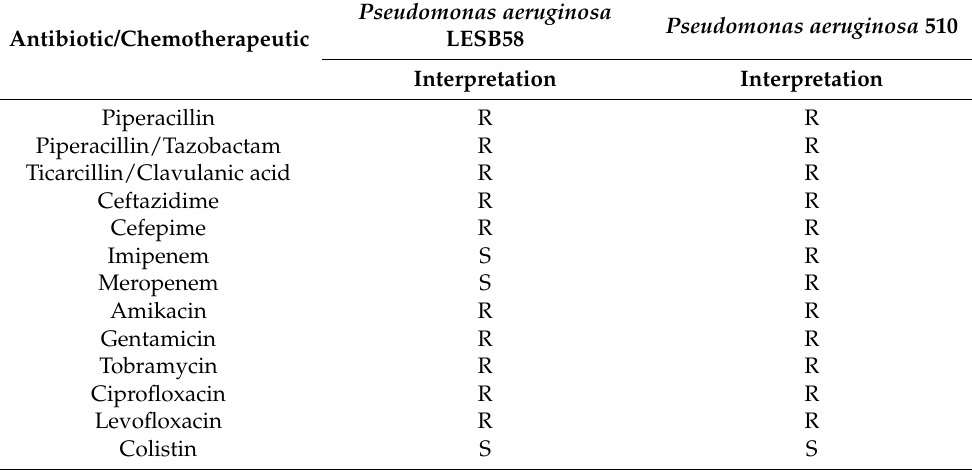
Table 4. Antibiotic susceptibility of Pseudomonas aeruginosa LESB58 and Pseudomonas aeruginosa